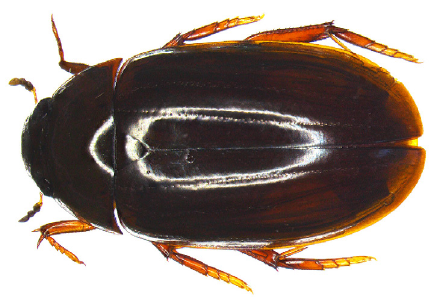
Figure 23. Hydrochara elliptica (Fabricius, 1801) 16.0 mm, iSimangaliso Wetland Park, False Bay (site 31), November 2013 MS Bird & R Perissinotto leg.